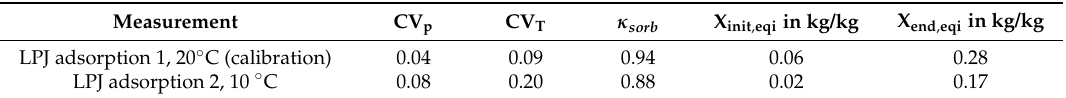
Figure 8. Surface temperature of sample 2_Fib measured in the experiments and simulated surface temperature for both calibration and validation measurement ( a ) and the corresponding pressure timelines in the dosing chamber ( b ). Table 10. Coefficient of variance for the simulation of two LPJ measurements with different initial conditions of sample 2_Fib.